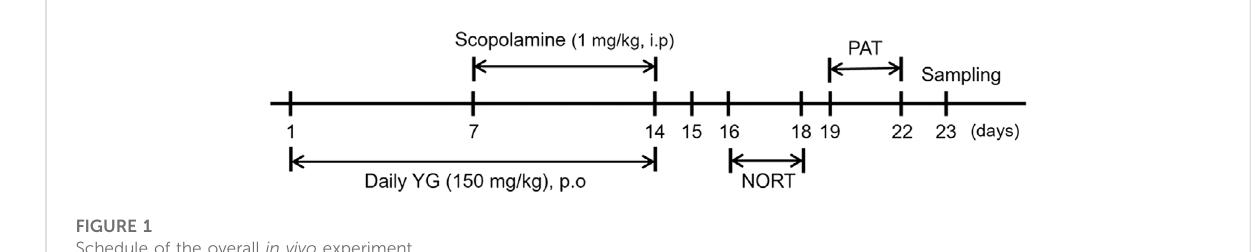
FIGURE 1 Schedule of the overall in vivo